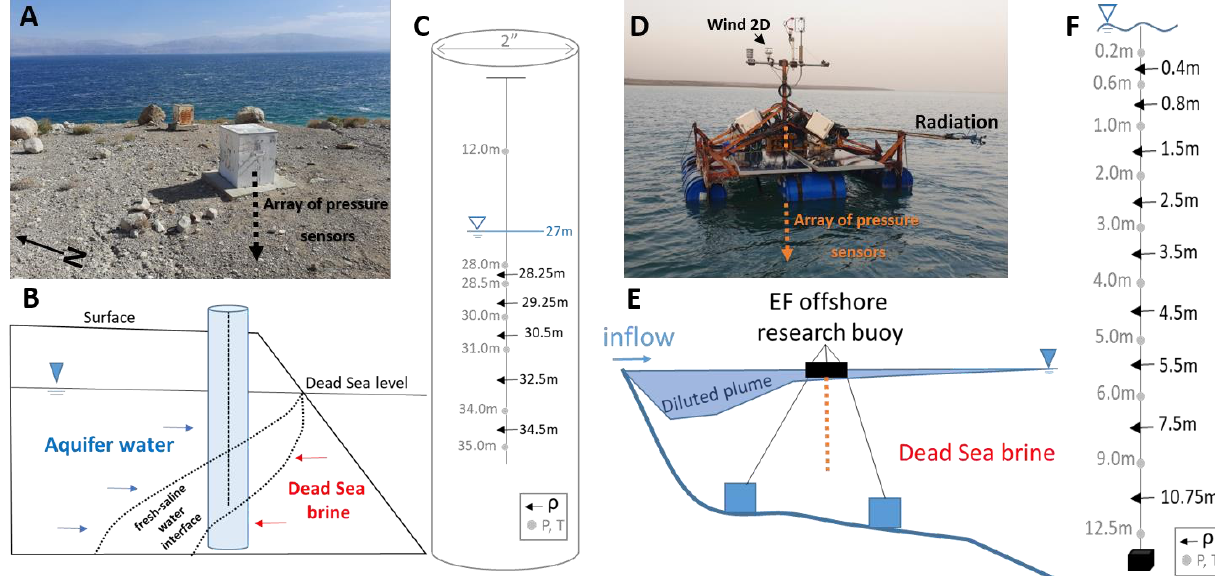
Figure 4. ( A ) EG26 borehole. ( B ) Schematic illustration of EG26 borehole. ( C ) Schematic illustration of the hydrostatic densitometer in the EG26 borehole. ( D ) Ein Feshkha (EF) research buoy. ( E ) Schematic illustration of EF buoy and the diluted plume due to freshwater inflow into the Dead Sea. The hydrostatic densitometer is represented by a dotted orange line. ( F ) Schematic illustration of the hydrostatic densitometer at the EF buoy.